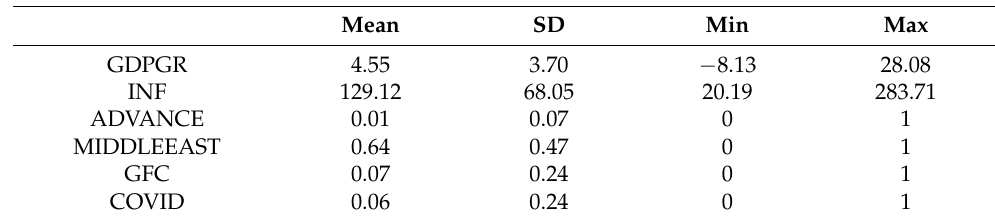
Table 2. Cont. 2B. The Determinants of DEA double Frontiers Efficiency